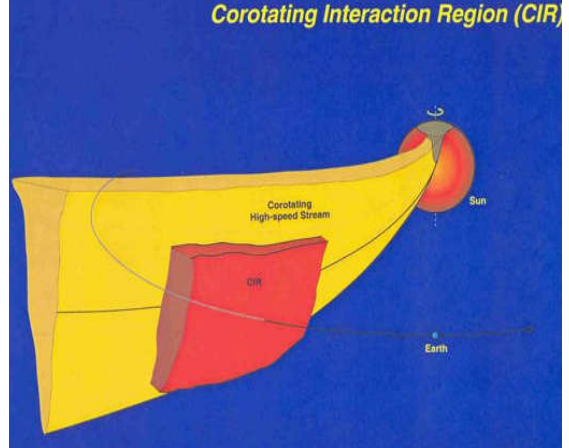
Fig. 4. A schematic showing how CIRs form at the leading edge of a high speed stream.